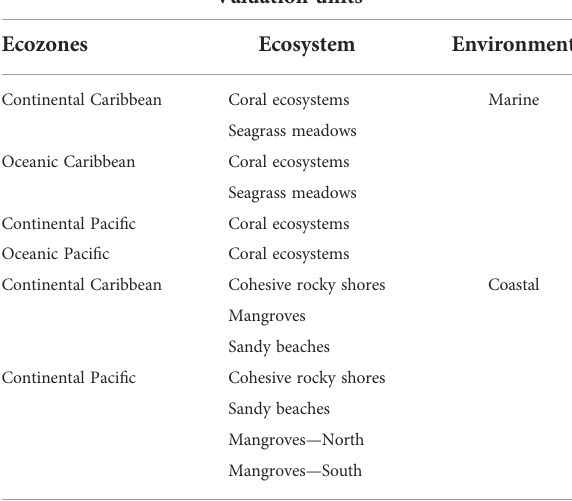
TABLE 1 Resulting valuation units for threat